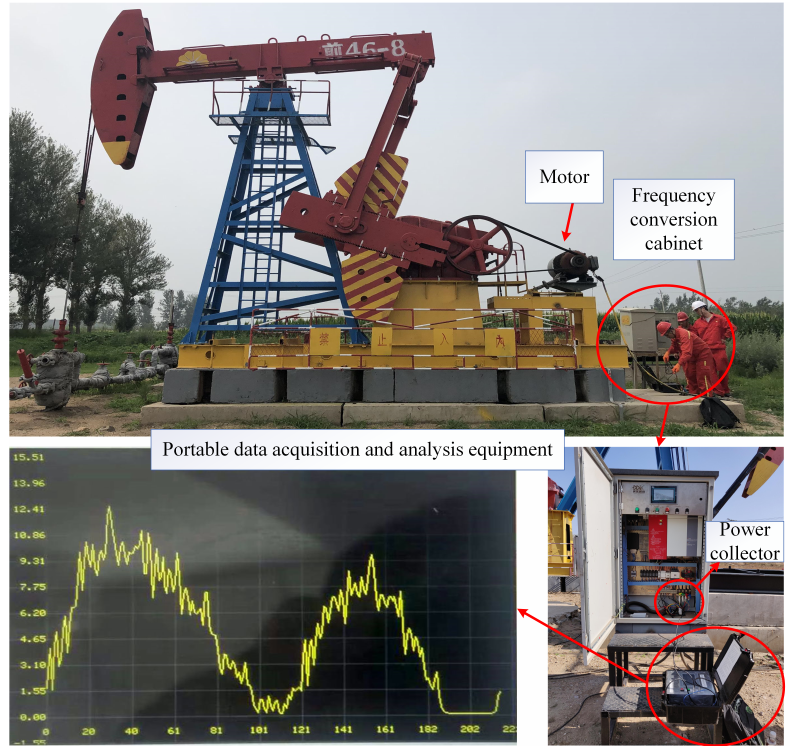
Figure 5. A self-developed data acquisition and analysis equipment employed in the